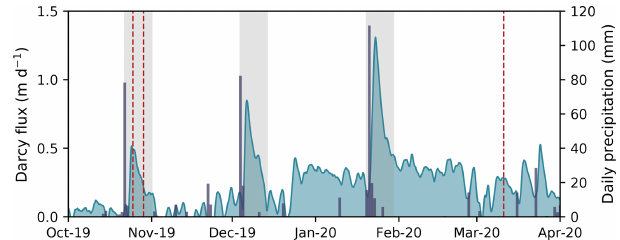
Figure B1. Temporal evolution of Darcy flux from October 2019 to April 2020 at the experimental site of the Argentona ephemeral stream. Red lines indicate the groundwater and seawater samplings performed at the study site (P1, P2, and BF) and gray bands